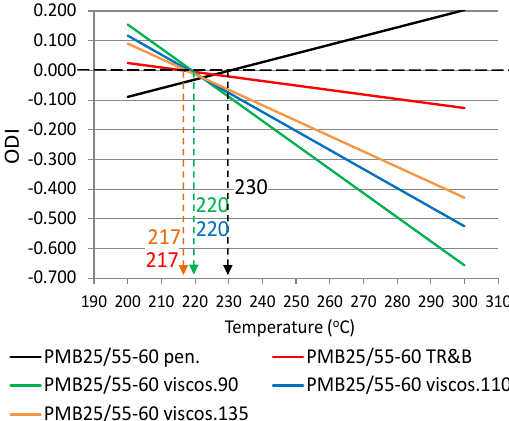
Figure 7. Overheating Degradation Index for binder PMB45/80-55 and determination of temperature T (ODI) . Materials 2019 , 12 , x FOR PEER REVIEW